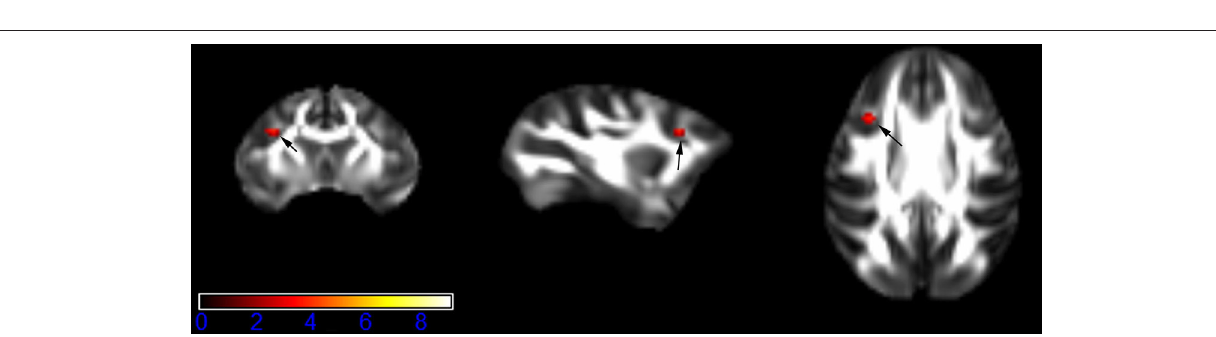
FIGURE 5 | Areas in inferior frontal gyrus WM (IFG-WM, left side) with reduced fractional anisotropy values in the chronic ketamine exposure group compared to controls at p < 0.005 (in red; uncorrected). The anatomical underlay is DTI-based monkey brain image template (UWRMAC-DTI271) FA map with white matter atlas. Figure from left to right side is coronal view, sagittal view, and axial view of the images, respectively. The color bar represents the t